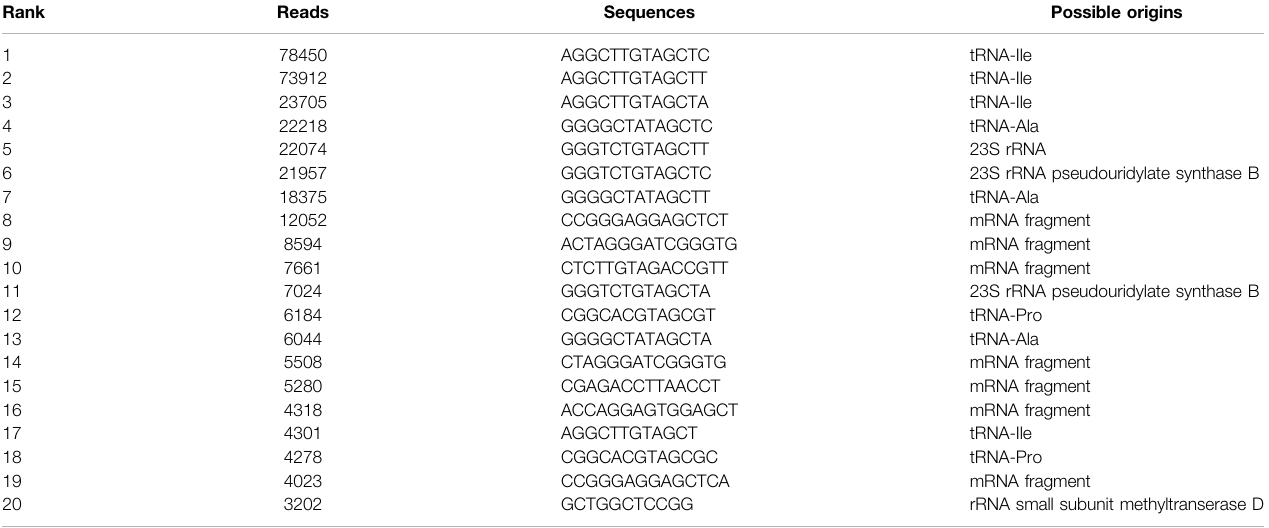
TABLE 2 | Top20 of the most abundant reads in OMVs